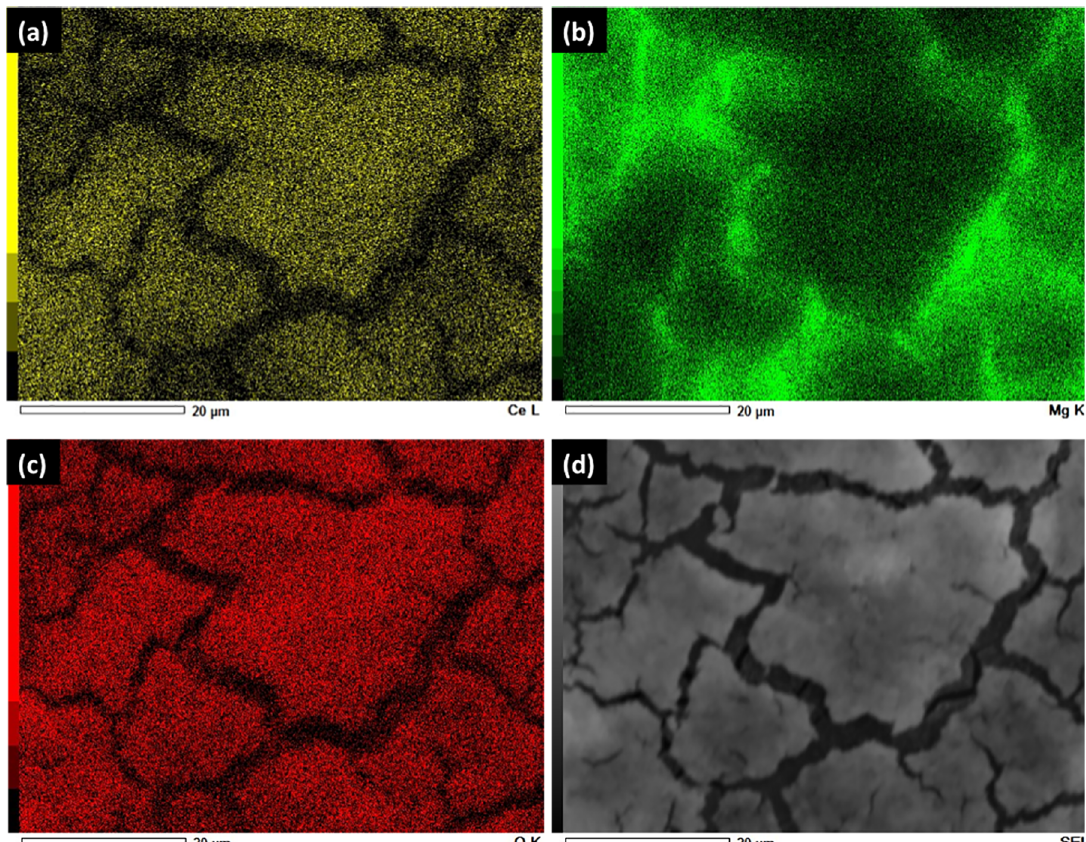
Figure 5. EDX maps for the AZ91D alloy after 60 s of immersion: a) Ce; b) Mg; c) O and d) SEI